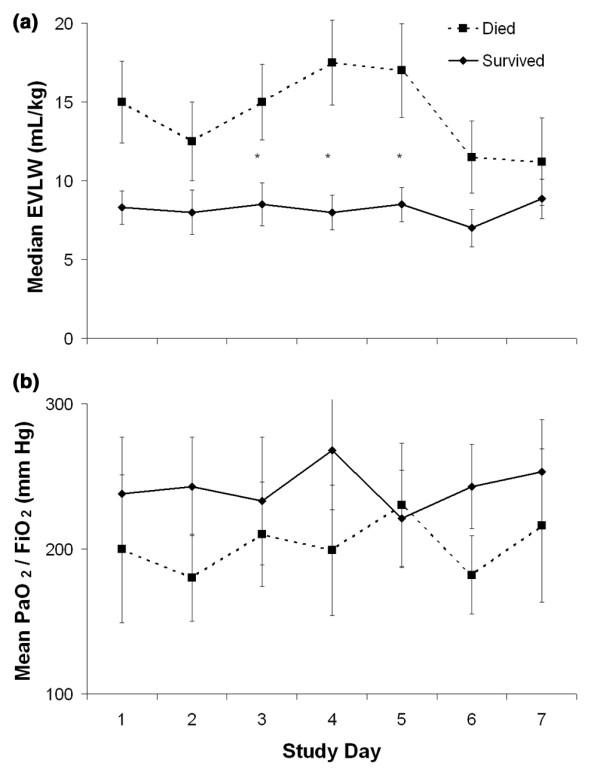
Longitudinal measures of (a) extravascular lung water (EVLW) and (b) oxygenation (arterial oxygen tension [PaO2]/inspired fractional oxygen [FiO2] ratio) in patients with severe sepsis, stratified by survival. Vertical bars indicate standard errors. *Significant between-group differences at the marked time points; P < 0.001 for EVLW differences over time, by analysis of variance.